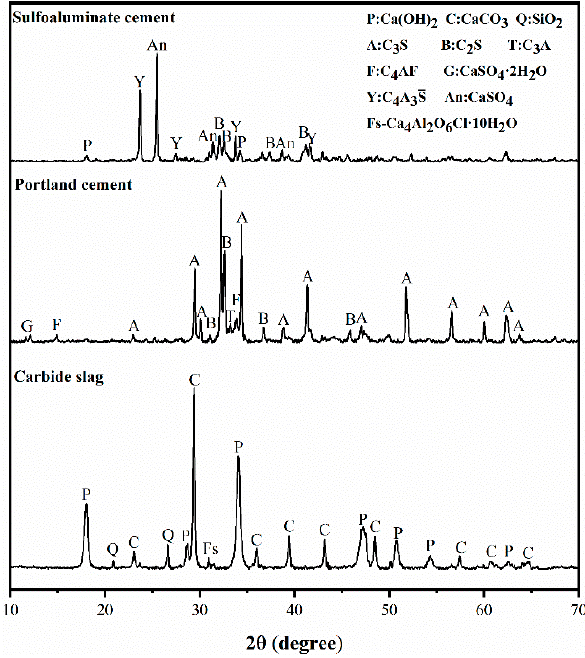
Figure 1. XRD patterns of raw materials used in this research.